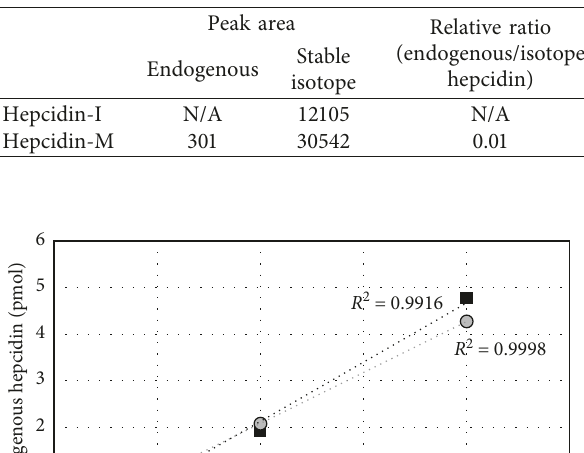
Supplementary 1 . Figure 1: MS/MS spectra according to different collision energy (CE) values. The red lettering in the spectral figure represented the y fragment ion selected for MRM assay. (a) and (b) are the MS/MS spectra of the 698.0 and 558.6 m/z derived from hepcidin-I. (c) and (d) are MS/MS spectra of 543.0 and 651.8 m/z derived from hepcidin-M. Supplementary 2 . Figure 2: the graphs show the extracted ion chromatography (EIC) of hepcidin-I (a) and hepcidin-M (b) obtained from SRM assay using 800 μ L of serum sample. Each EIC shows the peak intensity of endogenous- and SI- hepcidin (left) and also shows the peak intensity according to transitions (right).